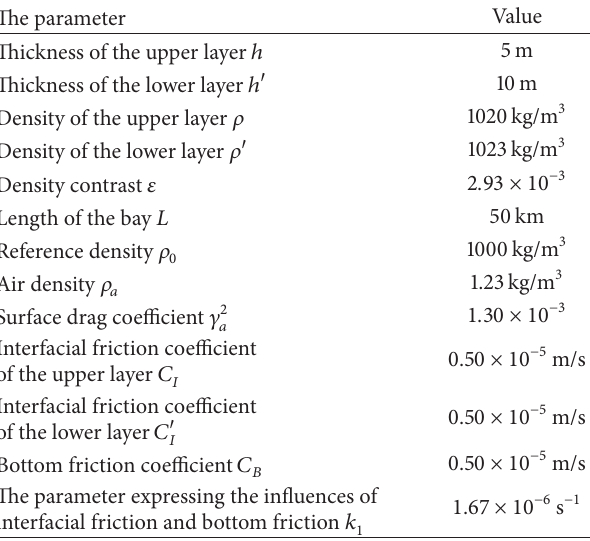
Table 1: Typical parameter values for Tokyo